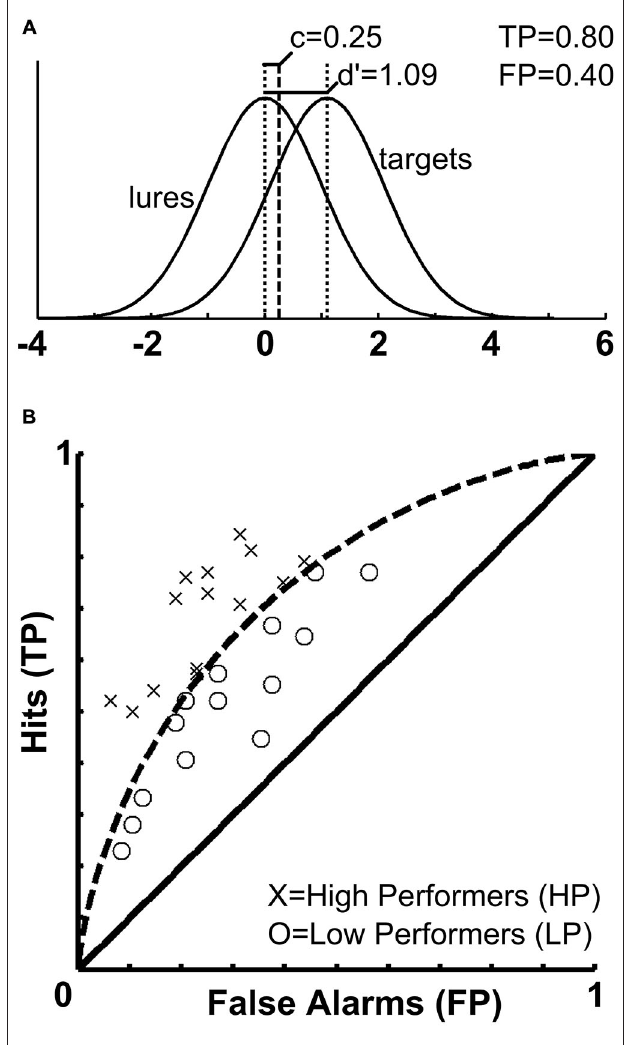
FIGURE 1 | Signal strength, decision criterion and receiver operating characteristics. (A) The upper panel illustrates the distribution of memory trace strength (d (cid:48) ) and decision criterion (c) in the current sample. Whereas (d (cid:48) ) is used to divide participants according to their behavioral performance and assess correlations with brain activity, (c) is used a covariate in the fMRI analyses to account for variance related to potential response bias. (B) The lower panel depicts the receiver operating characteristics (ROCs) space for the current sample. Based on the memory trace strength (d (cid:48) ), it was established that participants were categorized as HPs if they correctly classified at least 54 of the 96 old faces and at the same time, correctly rejected at least 27 of the 48 new faces. Accordingly, the curved dashed line separates the sample into HP and